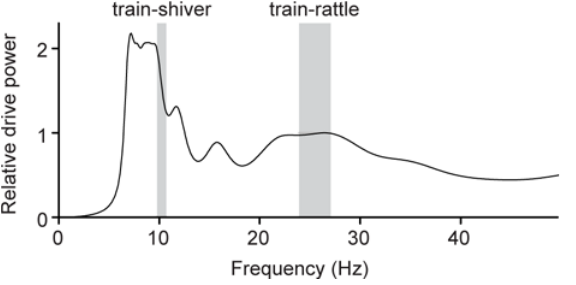
Fig 7. Predicted power spectrum for a peacock ’ s tail as a function of the vibrational frequency. These values were computed from laboratory data and the distribution of feather lengths in an individual peacock ’ s tail, using the mathematical model described in S8 Text. Note that “ tail ” refers to the array of rectrices, not the elaborate train. This model predicts that the tail has two broad resonant peaks near the average train- shivering and train-rattling frequencies that also agree with resonant peaks in the vibrational spectral response of the train array (Fig 5E). Gray shaded regions indicate the range of individual mean frequencies for shaking behaviors (Table